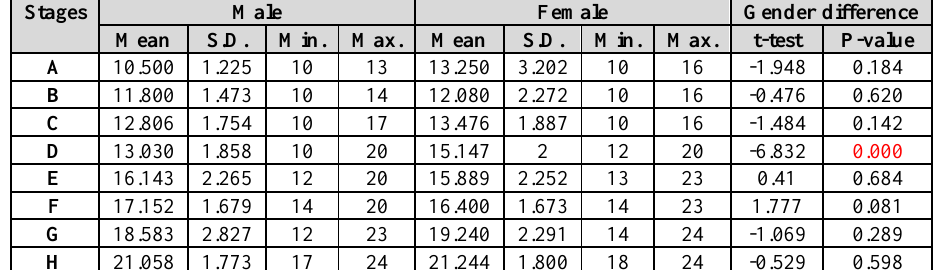
Table 3: Descriptive statistics and gender difference of age (in years) for different developmental stages of maxillary third molars Stages